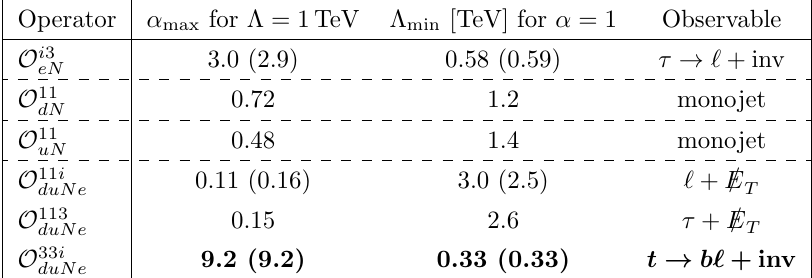
Table 5 . Maximum (minimum) value of (cid:11) ((cid:3)) for (cid:3) = 1 TeV ( (cid:11) = 1) allowed by the observables quoted in the last column for RRRR operators. The numbers outside (inside) the parentheses refer to ‘ = e ( (cid:22) ).